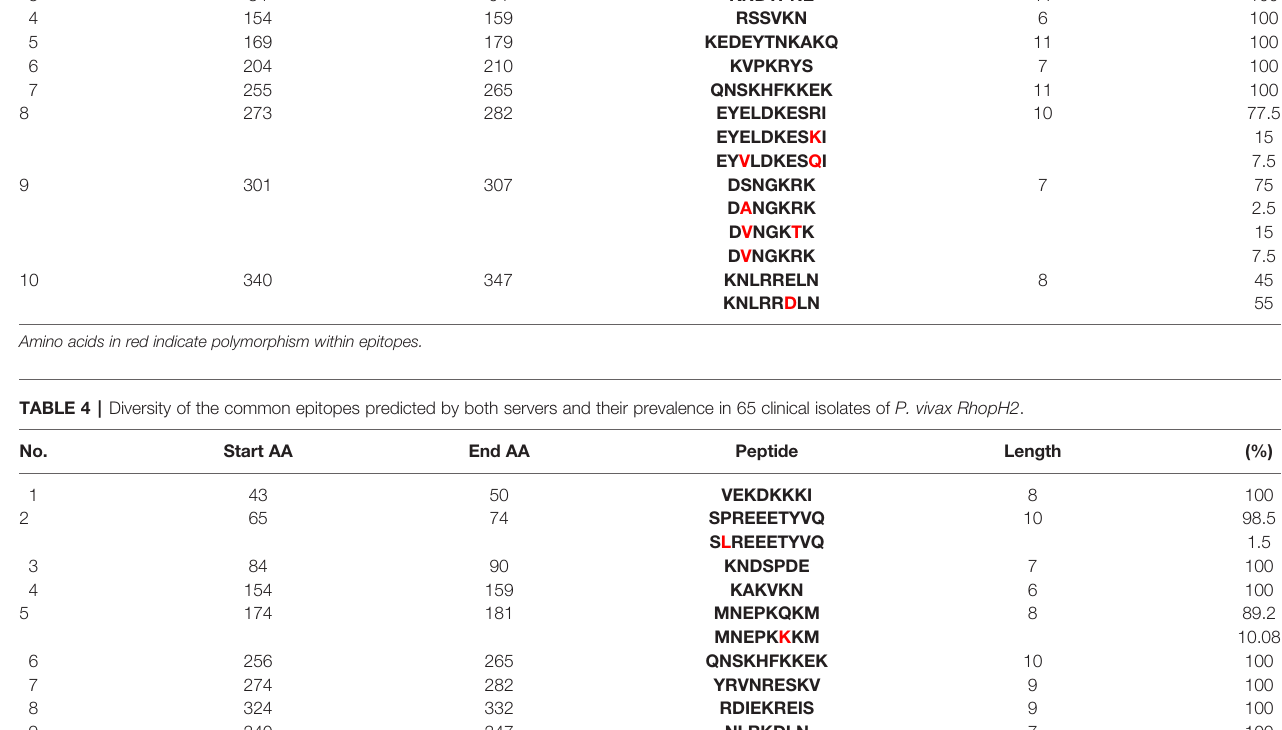
Amino acids in red indicate polymorphism within epitopes.